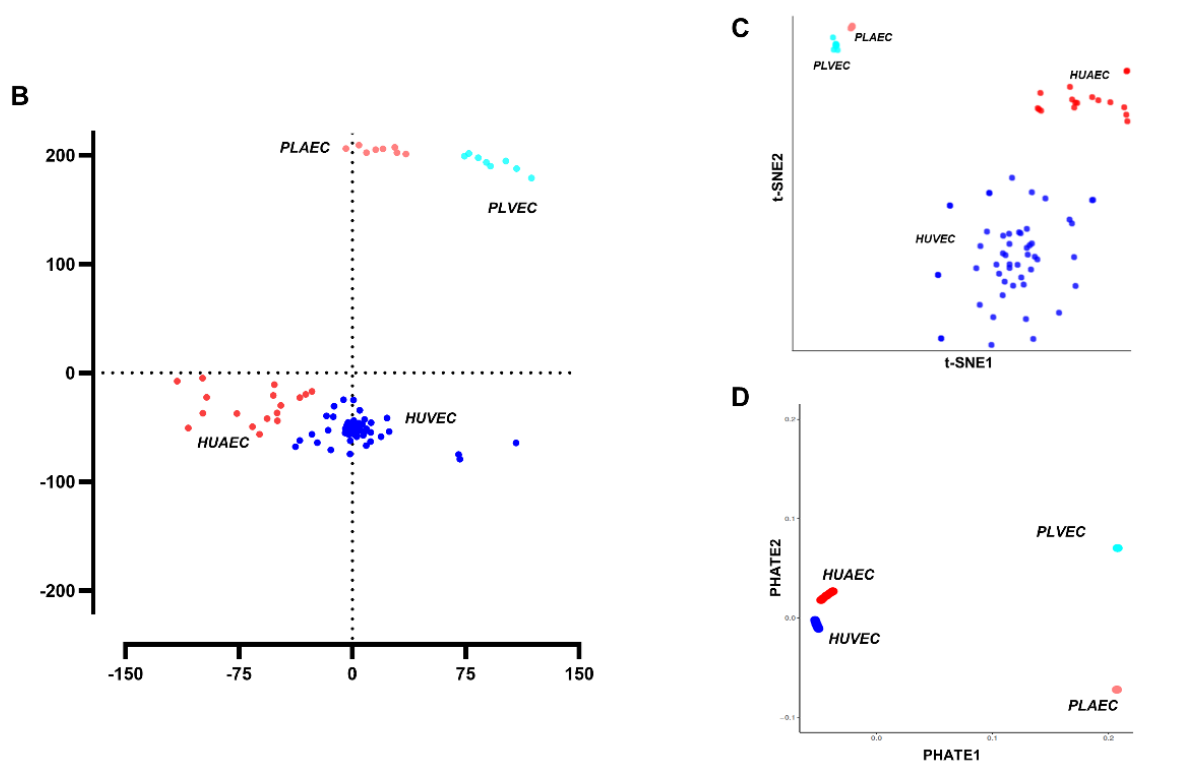
Figure 1. Transcriptional profiling, grouping, and proximity of umbilical and placental endothelial cells. ( A ) Hierarchical analysis of 17,280 transcripts commonly expressed in endothelial cells of the umbilical-placental bed. MDS ( B ), t-SNE ( C ), and PHATE ( D ) plots showing dissimilarities, similarities, and relative proximity among HUAEC (red dots), HUVEC (blue dots), PLAEC (light red dots), and PLVEC (light blue dots).